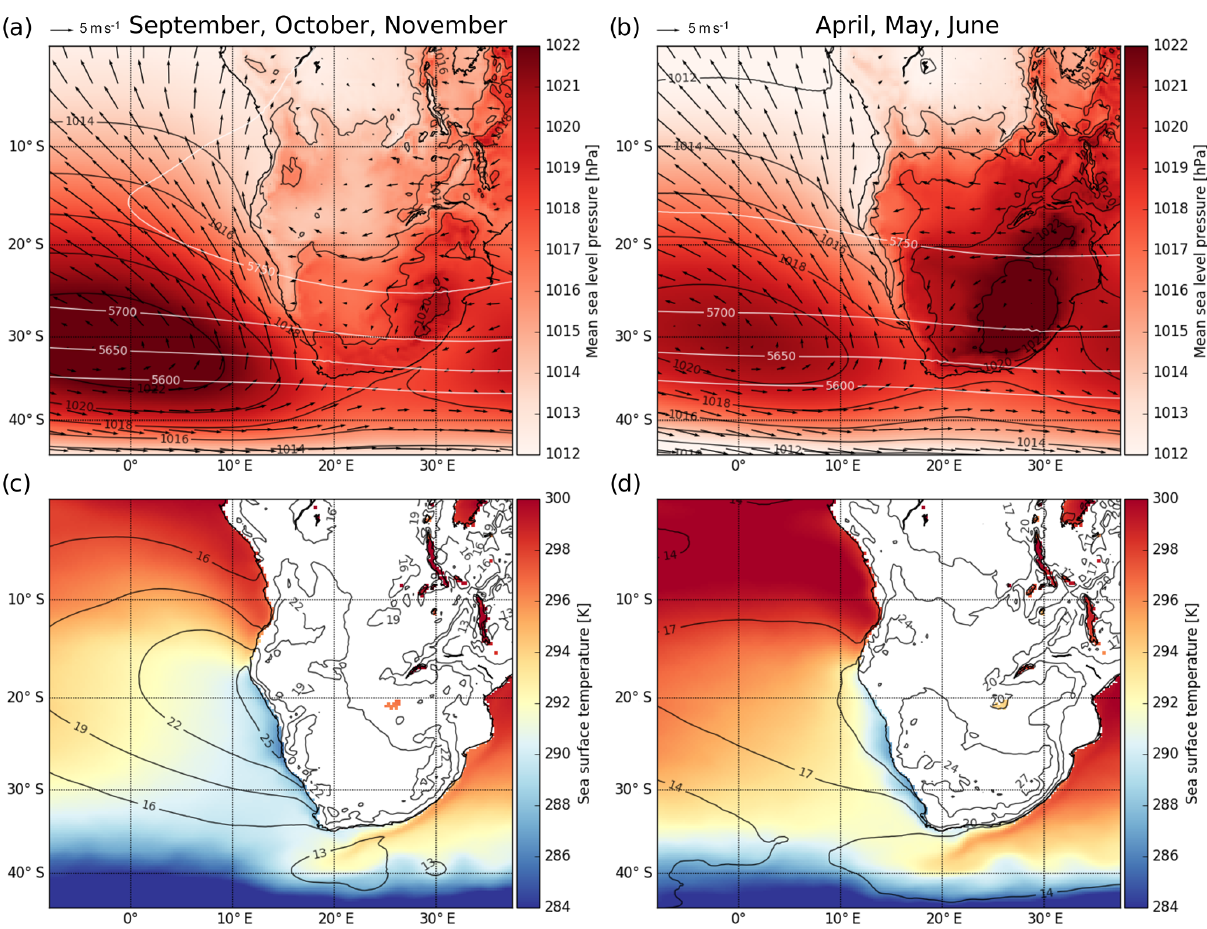
Figure 2. Climatological setting of the region in two seasons (2004–2017): (a, c) September, October, and November and (b, d) April, May, and June. (a, b) MSLP in color and contours with 10m winds indicated by arrows where the length scales with strength (the u and v vectors of near-surface winds are bilinearly interpolated to a 2 . 5 ◦ × 2 . 5 ◦ grid for clarity). Z500 is illustrated with white contours. (c, d) SST in color and LTS (in kelvin) as contours. Data are sampled at